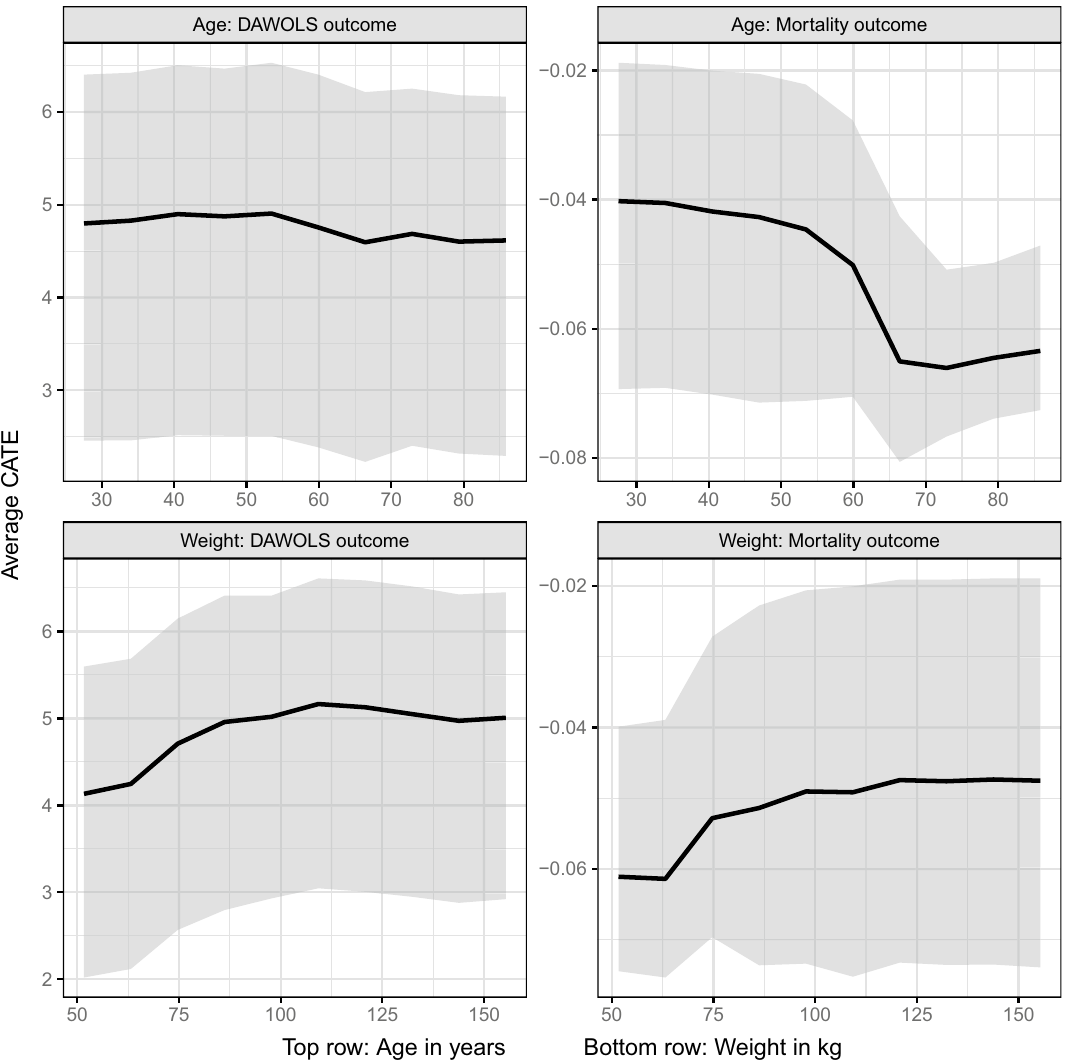
Figure 2. Partial dependence plots exploring how the conditional average treatment effects vary across the continuous covariates. The top row of panels displays results for the age covariate, while the bottom row displays results for the weight covariate. Within each row, the left panel displays estimates (solid line) and 95% credible intervals (shaded area) for the difference in days without life support at 90 days, while the right panel displays estimates (solid line) and 95% credible intervals (shaded area) for the mortality risk